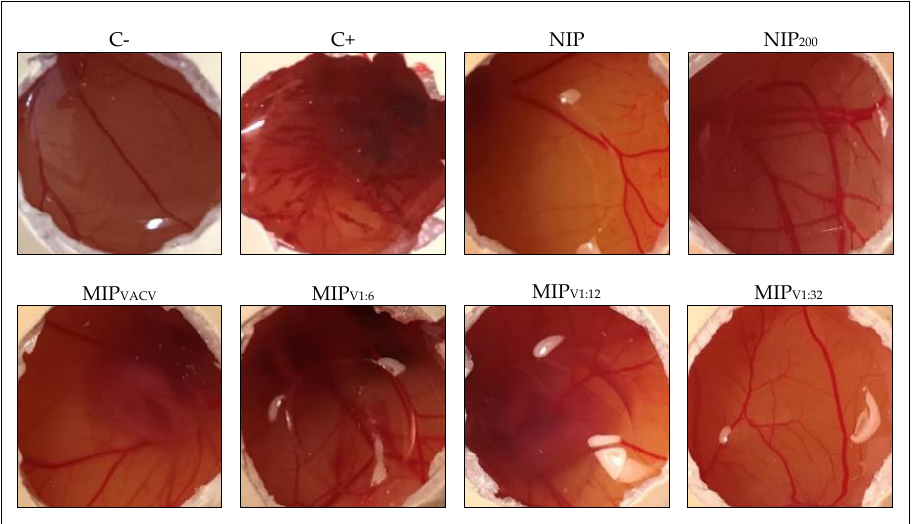
Figure 7. Pictures of chorioallantoic membranes during the hen's egg test on chorioallantoic membrane (HET-CAM) test after 5 minutes of contact with VACV-loaded hydrogels. The negative (C-) and positive (C+) controls refer to 0.9% NaCl and 0.1 N NaOH solutions, respectively.